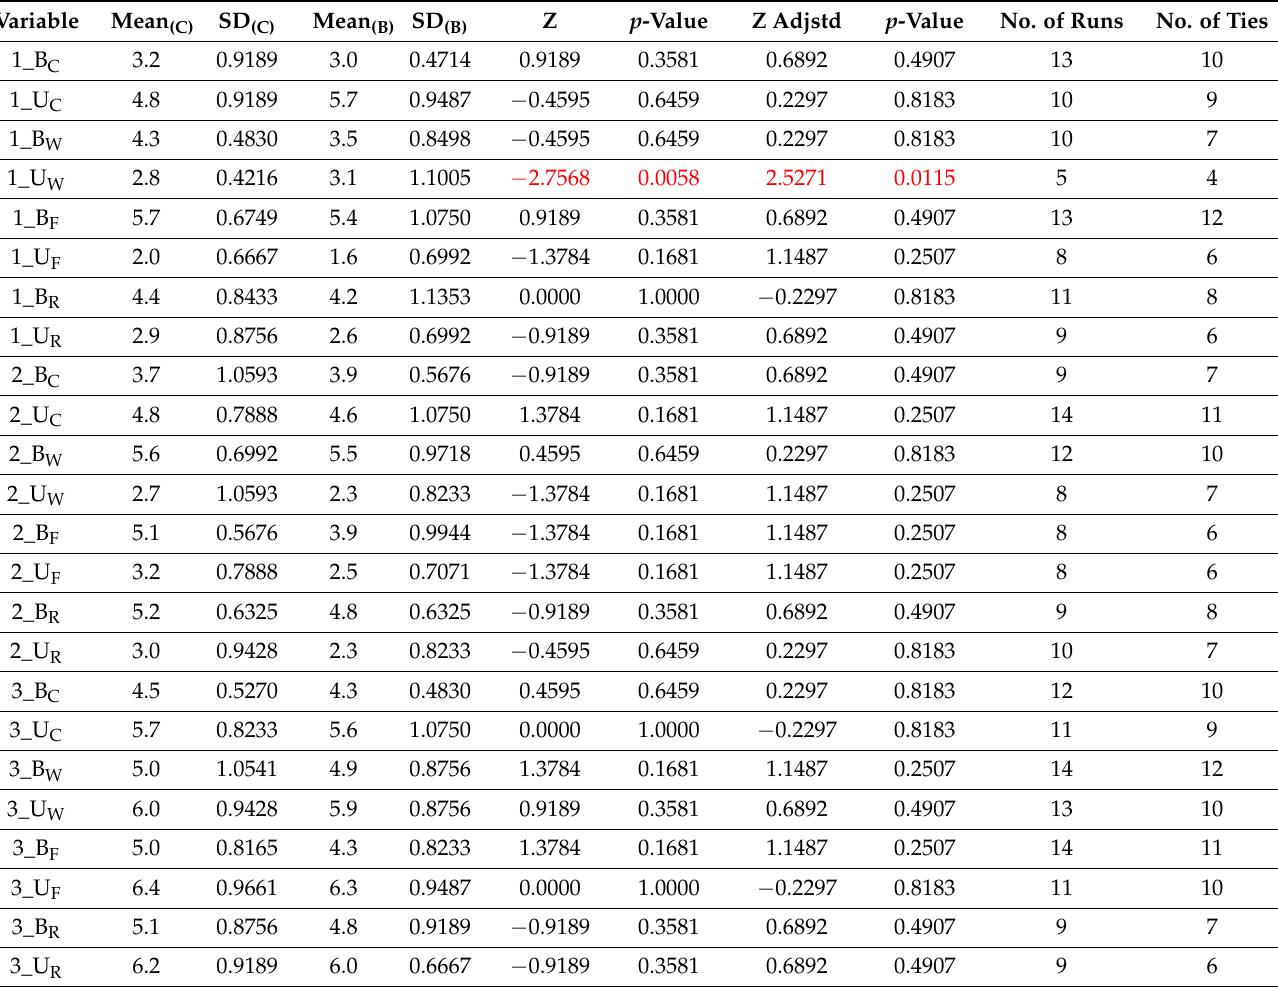
Table 4. The Wald–Wolfowitz runs test results (Valid N (C) = 10, Valid N (B) =